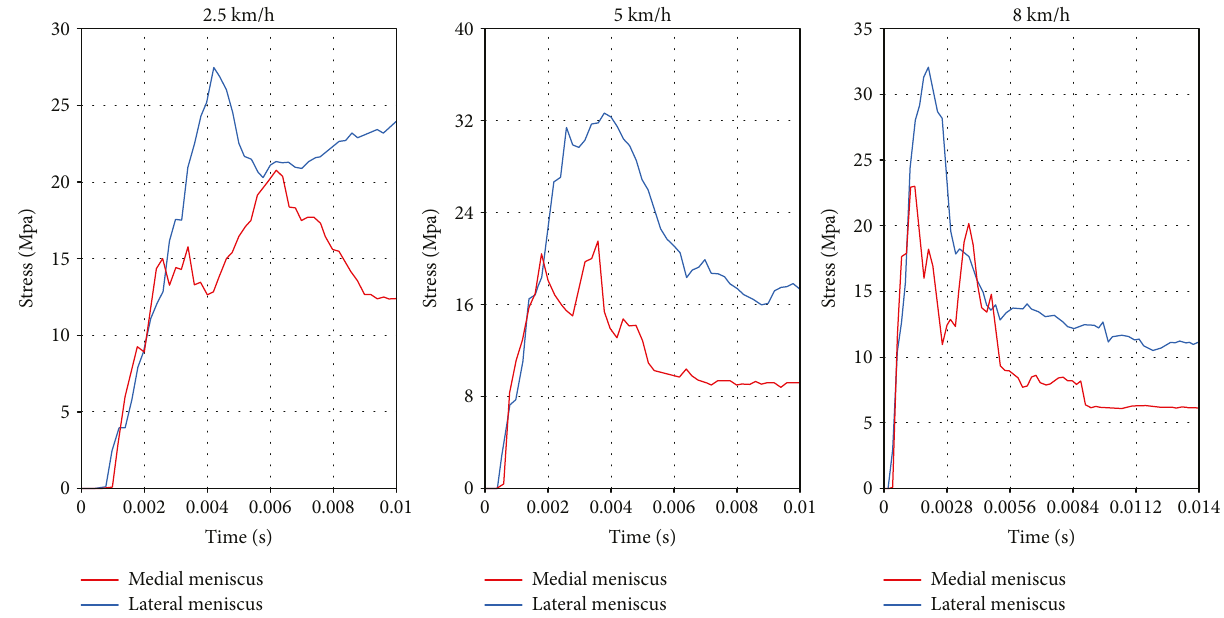
Figure 10: Meniscus stress curves at the varied impact speeds.